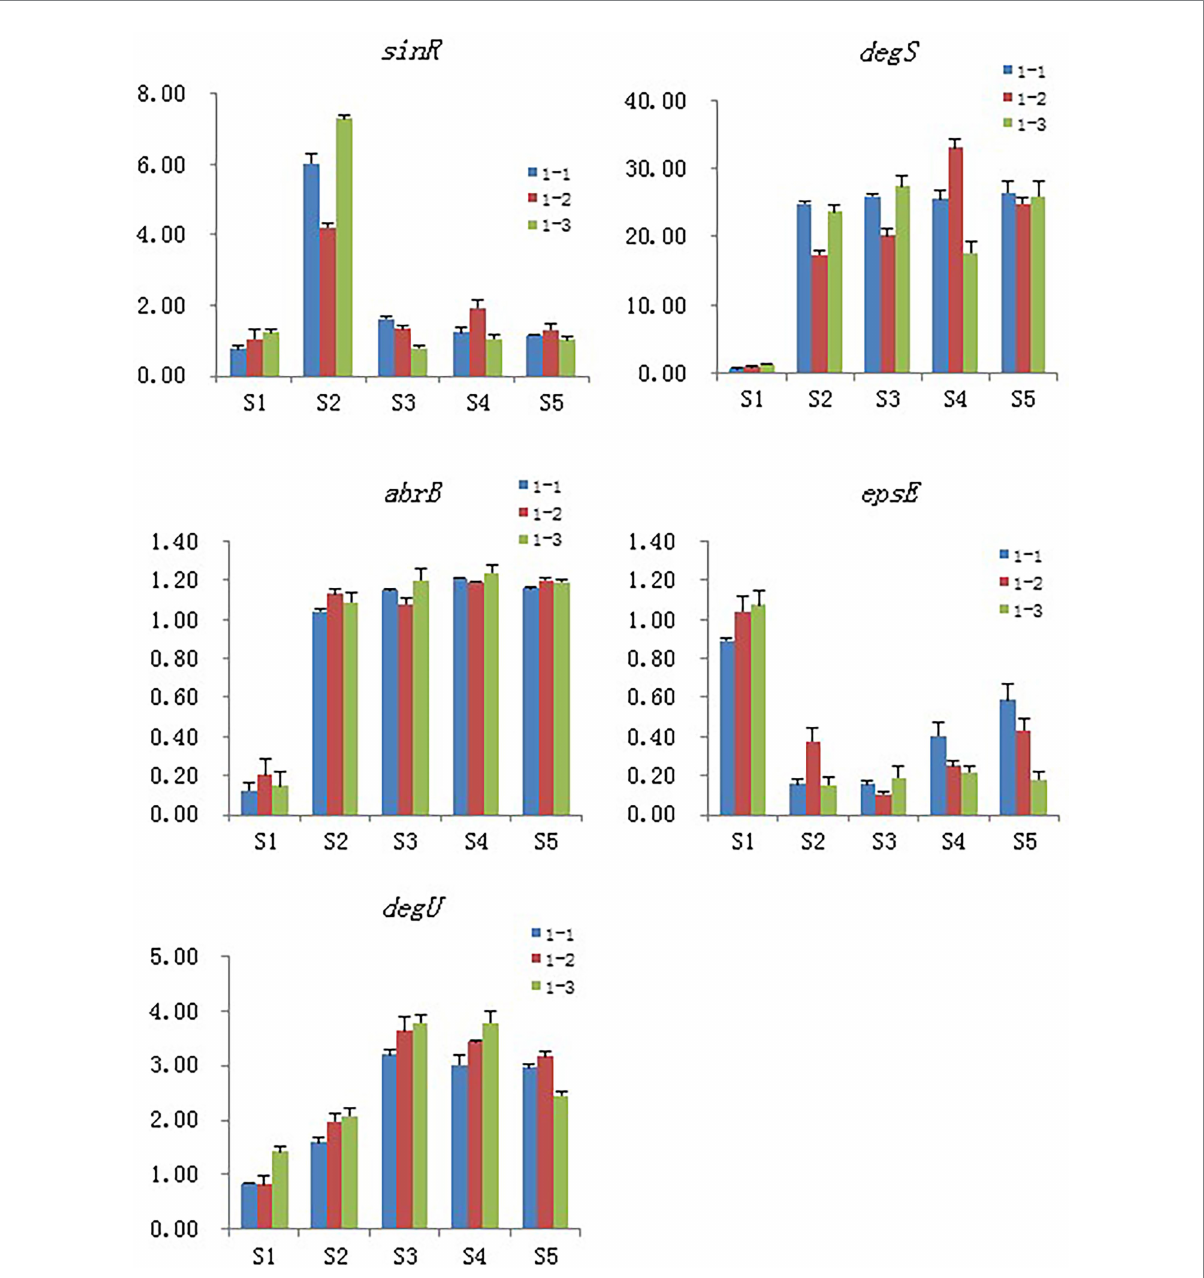
FIGURE 9 Validation of the selected DEGs by real-time PCR. Samples collected at 6 h, 12 h, 18 h, and 24 h were named as S2, S3, S4, S5 and the blank control that without Cd2 + was named as S1, 1–1, 1–2 and 1–3 means the three replicates of each